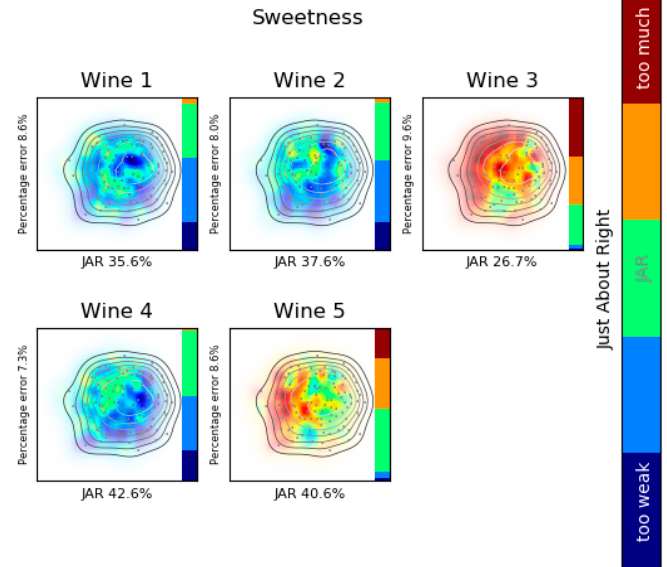
Figure 10. Attribute analysis: Sweetness. Liking product landscape, consumers’ map created with MDS fed with OLJAR and product acceptance map created with SVM.